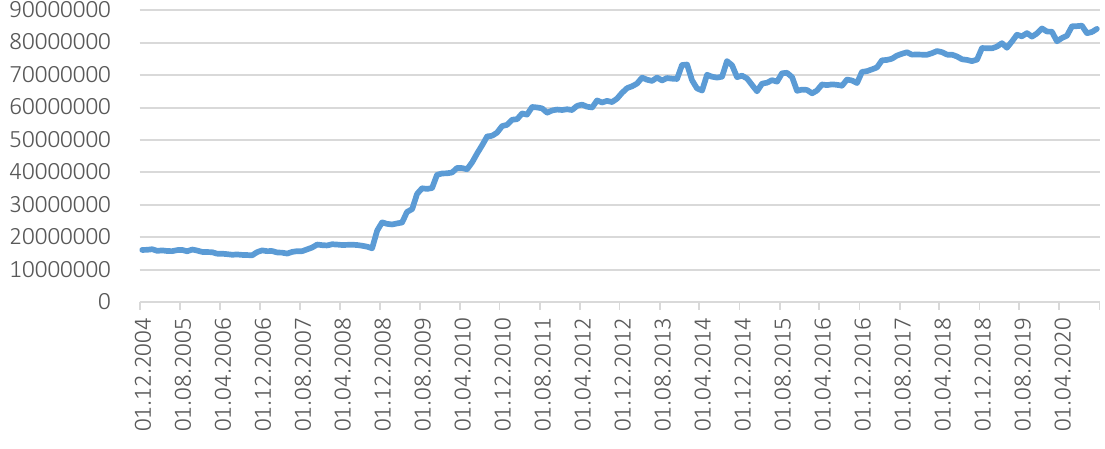
Figure 4. Time series graph of the State Debt of Ukraine 2004–2020, USD